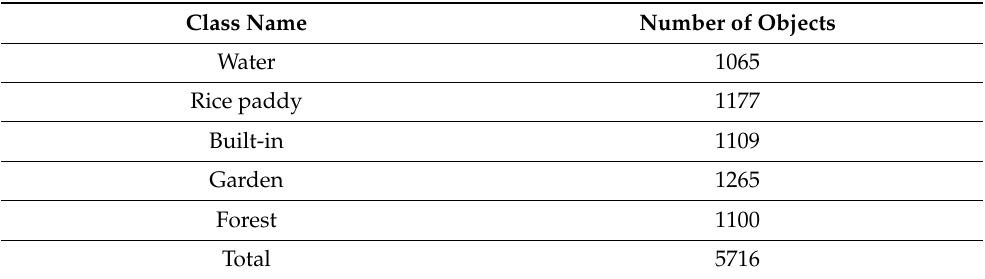
Table 2. Training set for MLP andRF descriptions.